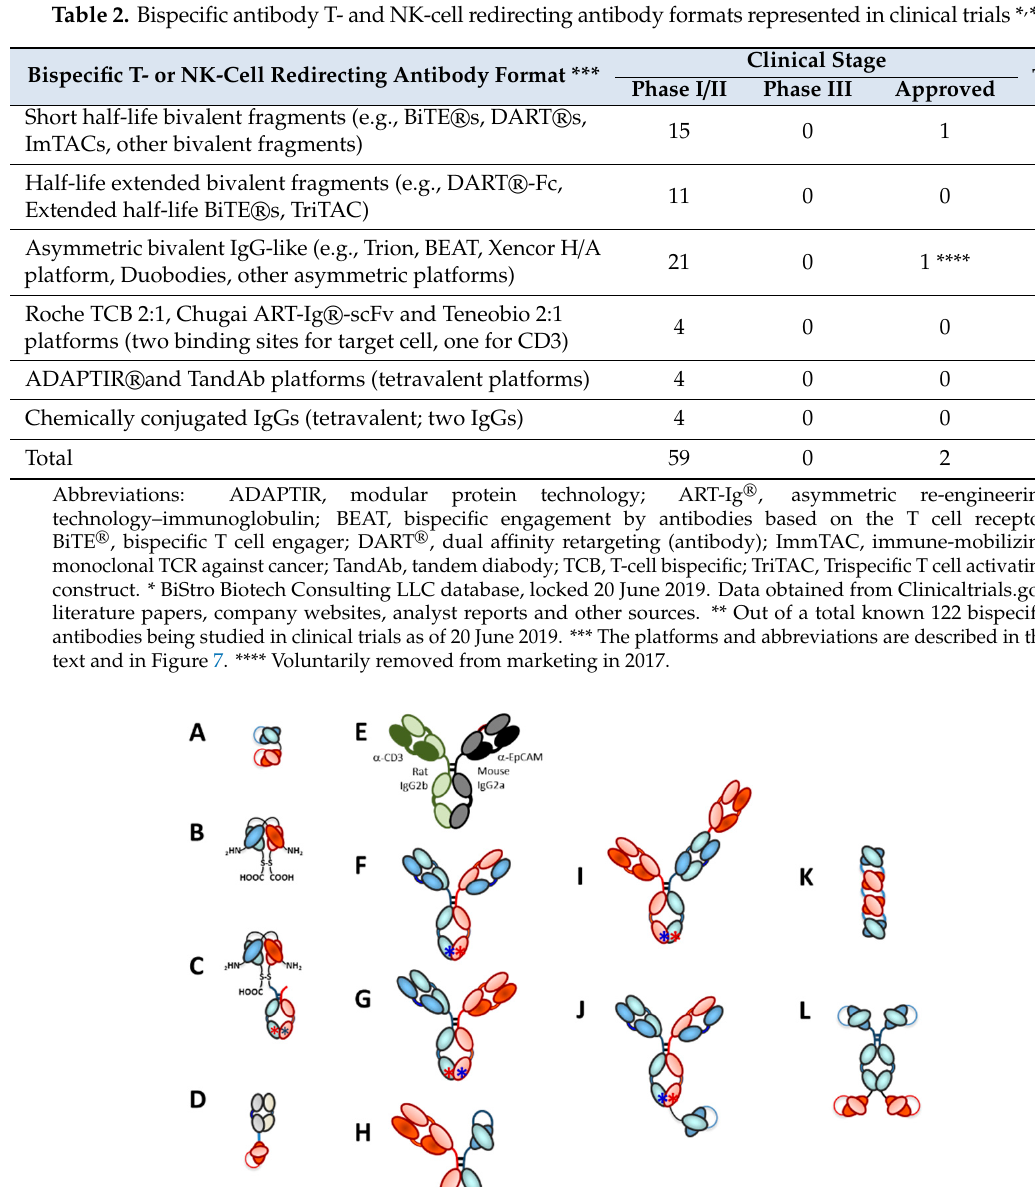
fused to one HC to make an ART-Ig ® -scFv 2:1 (target cell antigen:CD ε ) antibody; ( K ) tetravalent,